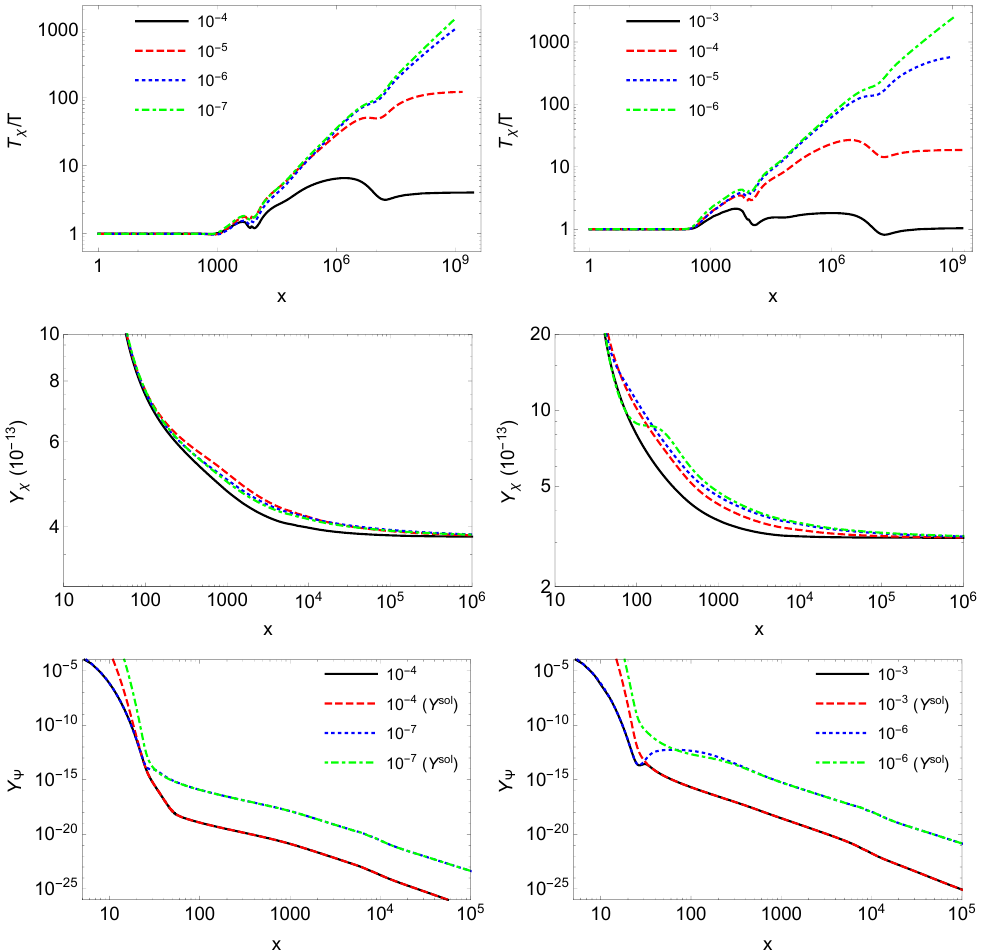
Figure 5 . DM temperature T (cid:31) (top), DM number density Y (cid:31) (middle), and dark partner number density Y (cid:9) (bottom) as a function of the SM inverse temperature x for the S2B (left) and 3B (right) decay modes and (cid:14) = 10 (cid:0) 7 . The top two rows plot four di(cid:11)erent values of the resonance width parameter (cid:13) as labelled in the top line. The bottom row shows both the results of our numerical integration and the approximation of eq. (2.7) for two values of (cid:13)